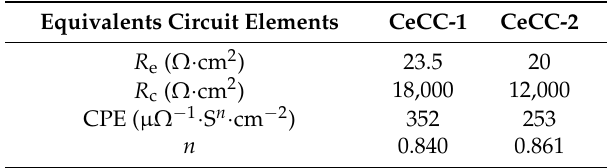
Table 3. Values of fitting analysis of the experimental EIS data employing the